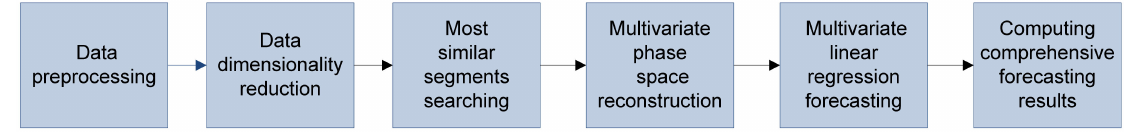
Figure 1. Flow diagram of ultra-short-term wind power prediction